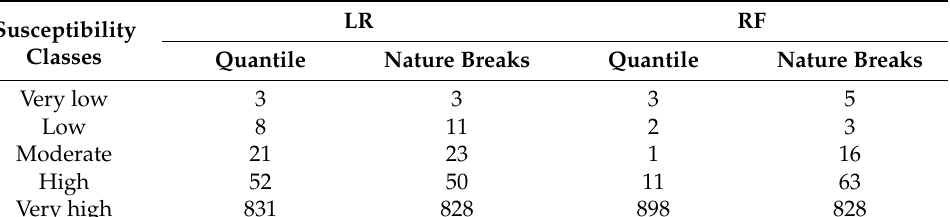
Table 2. Numbers of historical flash flood events that occurred in regions with various susceptibility classes.